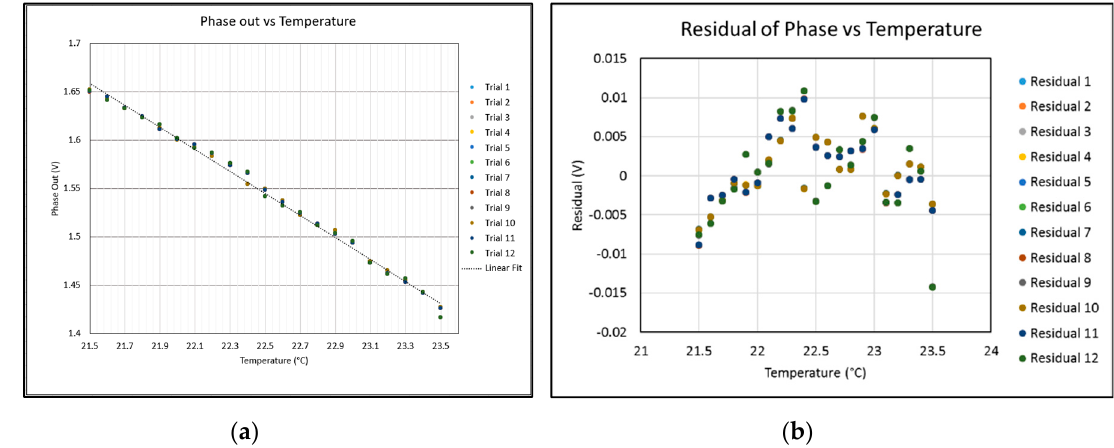
Figure 10. Results of 21.5 to 23.5 °C range in 0.1 °C steps ( a ) Phase output vs. temp; ( b ) Residual plot.